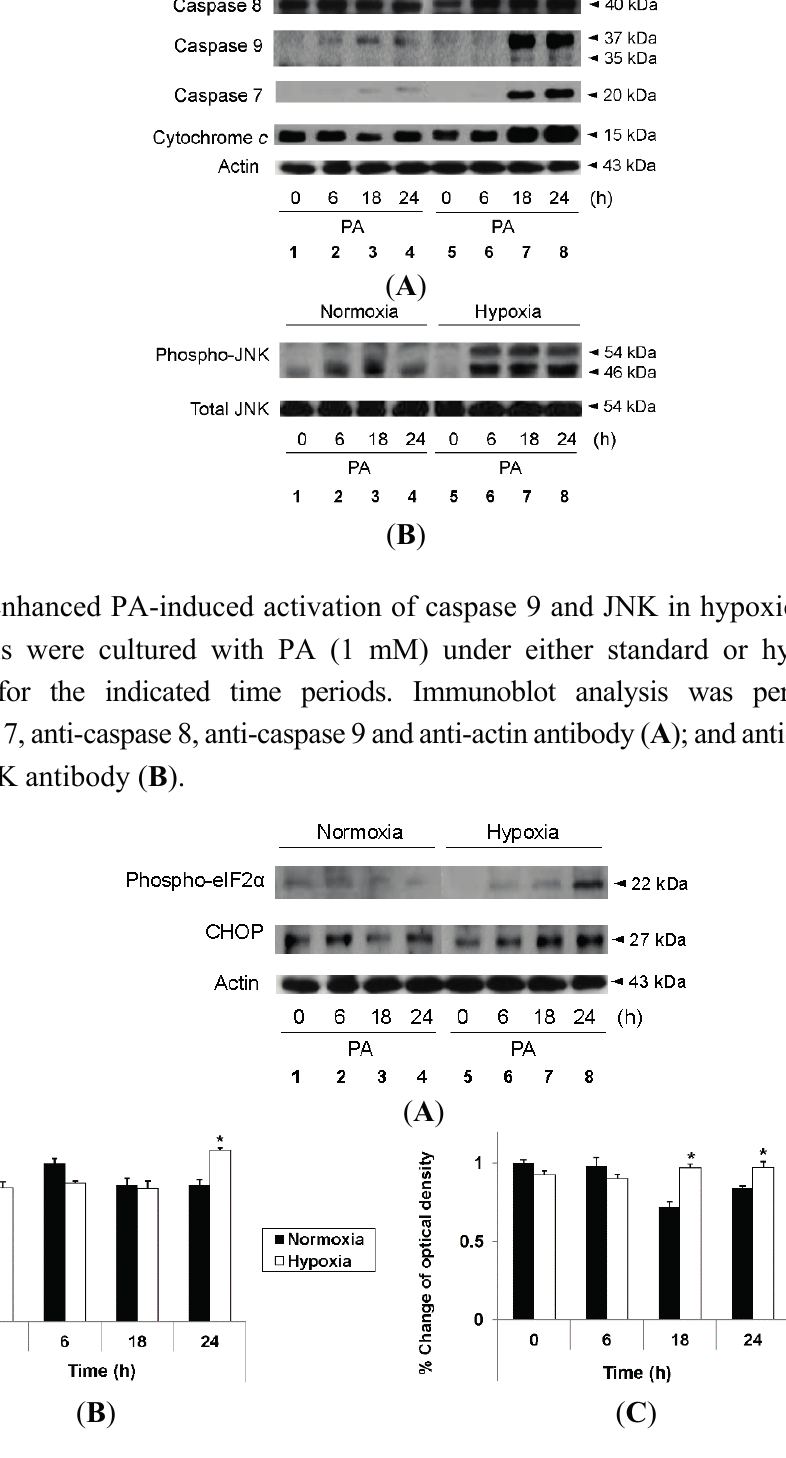
Figure 4. Enhanced PA-induced ER stress in hypoxic hepatocytes. HepG2 cells were cultured with PA (1 mM) under either standard or hypoxic culture conditions for the indicated time periods. Immunoblot analysis was performed using anti-phospho-eIF2a, anti-CHOP and anti-actin antibody ( A ); Densitometric evaluation was performed for anti-phospho-eIF2 α ( B ); and anti-CHOP ( C ). Data are expressed as the mean ± standard deviation of the percent change of optical densities compared to Time 0 h. * p <